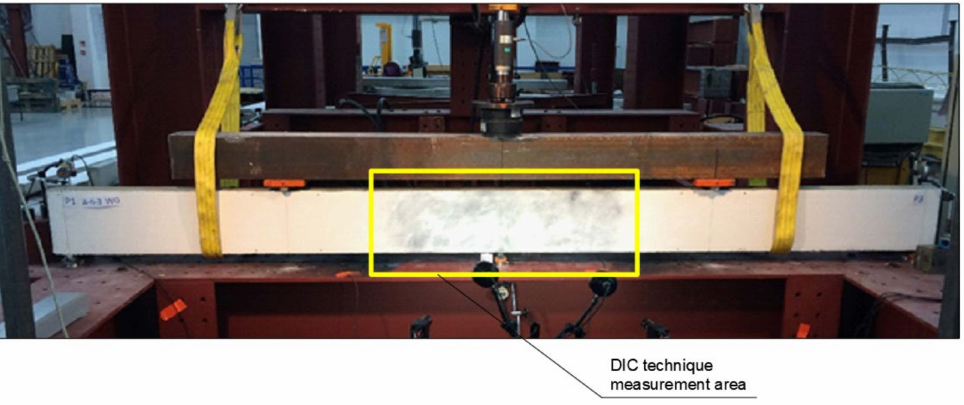
Figure 4. View of the measuring